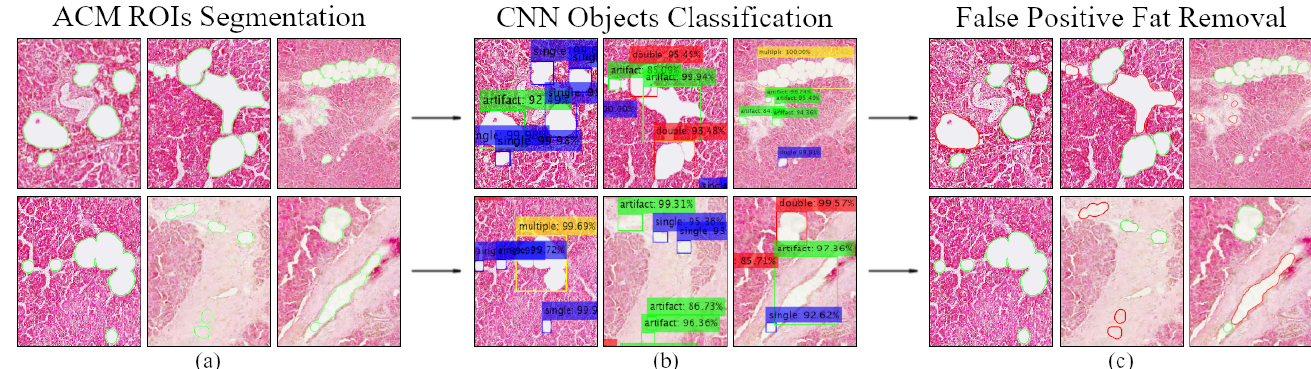
Figure 6. Visualization of the pancreatic fat quantification method in 20 × microscopic specimens: ( a ) segmentation result of circular-bright regions of interest (ROIs), with active contour models (ACMs), as candidate lipocytes; ( b ) calculation of the bounding box for each ACM-segmented object and identification of actual fat accumulation areas with the ensemble CNN classification system; ( c ) excluding most false-positive fat structures (red contours) from fat ratio